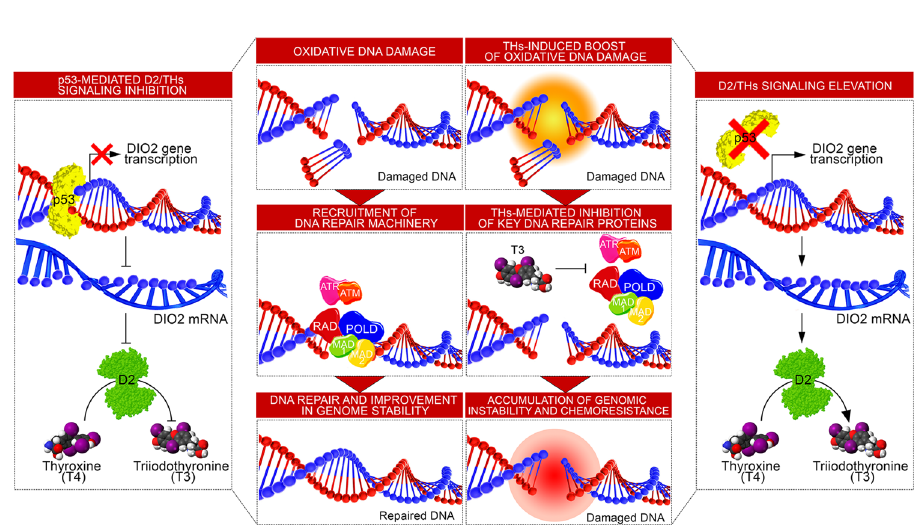
Fig. 8 | Loss of p53 leads to D2 re-expression and enhanced DNA damage. Graphical illustration of the p53-mediated D2 regulation and the transcriptional program leading to modulation of genes involved in the DNA Damage Response